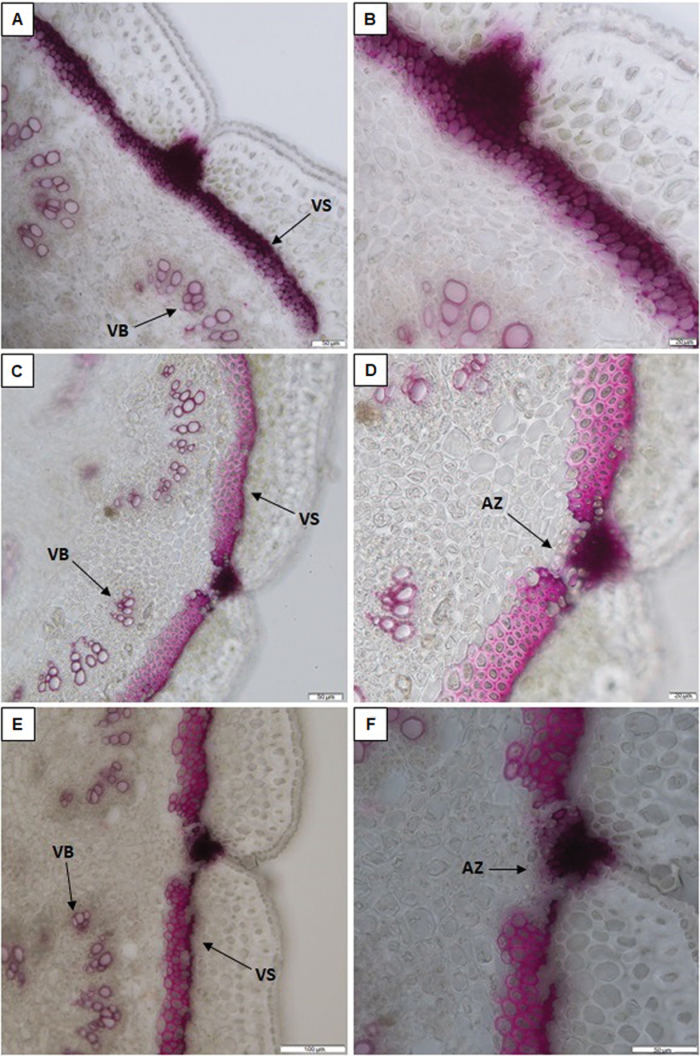
Analysis of lignification patterns in the ventral sheaths of 10-day-old pods of the totally indehiscent variety Midas and the highly dehiscent RIL MG38 and IL 244A/1A. Cross-sections (section thickness, 30 µm) of pods of Midas (A, B), MG38 (C, D), and 244A/1A (E, F) after phloroglucinol staining for lignin. (B, D, F) Increased magnification from (A, C, E). Scale bars: 50 µm (A, C, F); 20 µm (B, D); 100 µm (E). VS, ventral sheath; VB, vascular bundles; AZ, abscission zone.